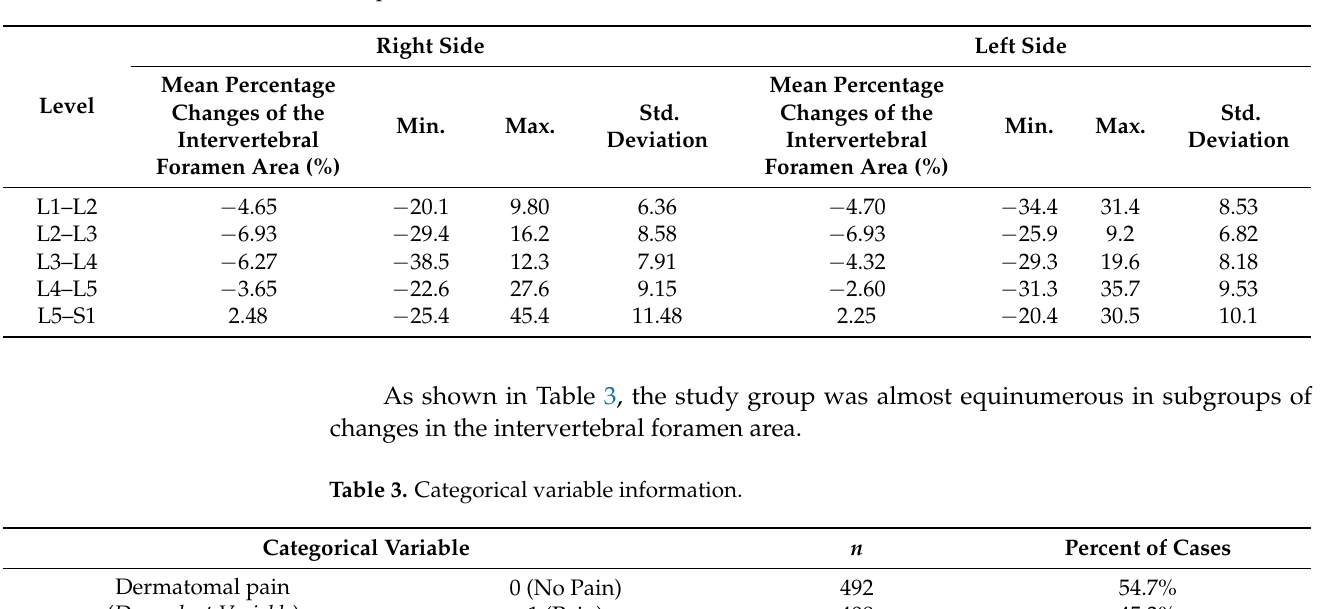
Figure 4. Error bar plot of the loaded-unloaded changes in the intervertebral foramen area at each vertebral level on the right side ( top ) and the left side ( bottom ). Circles represent mean values of the percentage changes in the area of the intervertebral foramen, and the vertical line segments indicate a 95% confidence interval. Table 2. Average percentage changes in the intervertebral foramen area by side and the level of the spine.